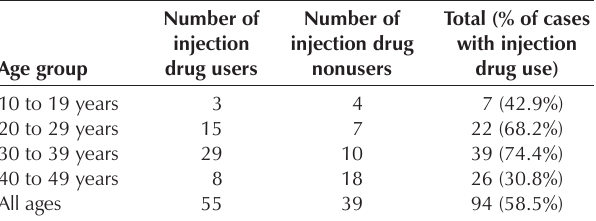
Age distribution of invasive group A streptococcus cases in relation to defined injection drug use, British Columbia,